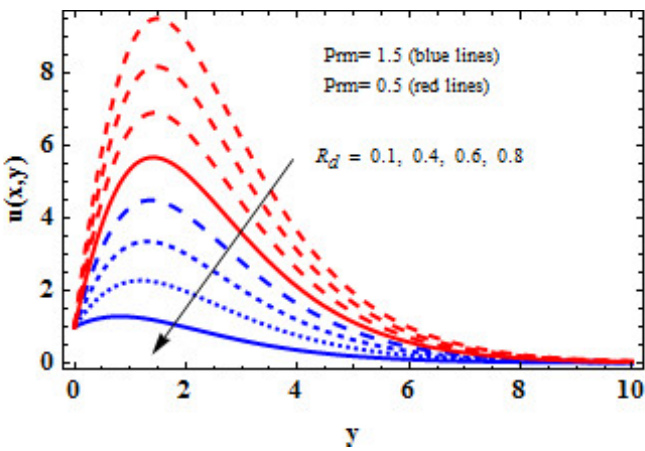
Figure 12. R d effect on concentration with respect to Prm .